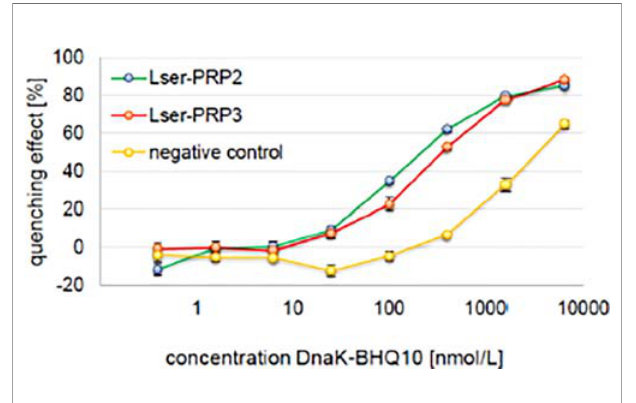
FIGURE 2 | Quenching ef fi ciency of Lucilia sericata proline rich peptides (PRPs) in comparison to the negative control apidaecin 1b (9 – 18) in the presence of increasing concentrations of BHQ10. The DnaK-binding curve of Lser-PRP2 and Lser-PRP3 appeared sigmoidal. As a result, the effective quenching (with maximum quenching effect of >80%) of fl uorescence is achieved by the BHQ10 fl uorophore indicating the effective interaction of both peptides with bacterial DnaK, which can lead to interference with DnaK functions. Data are means ± standard deviations (n=3).